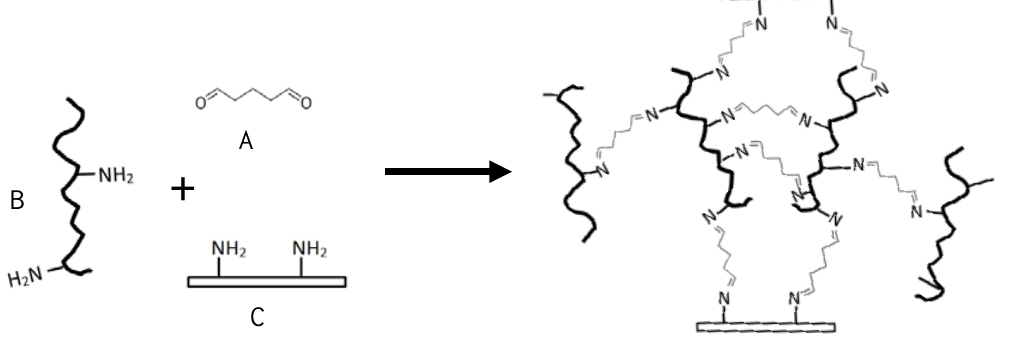
Figure 1. Reaction mechanism of protein polymer and GTA adhesive to bond tissue cells. (A) GTA; (B) protein polymer molecules; and (C) tissue or organ proteins.